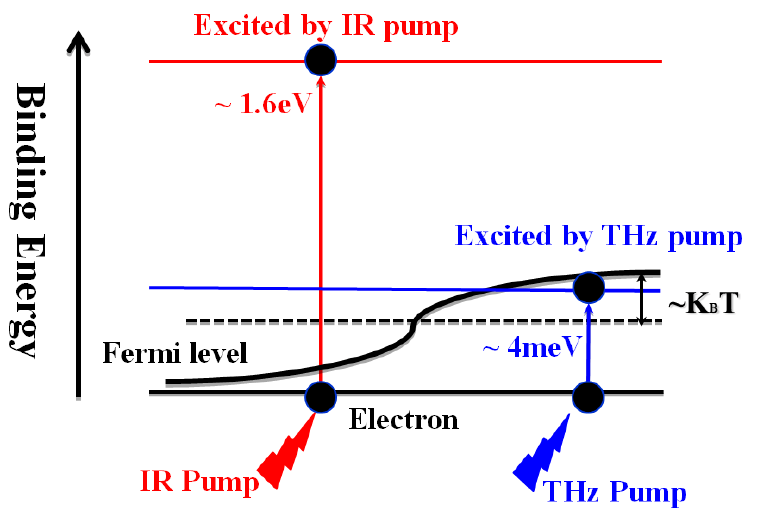
Figure 1. Comparison between IR pump and THz pump in terms of photon energy